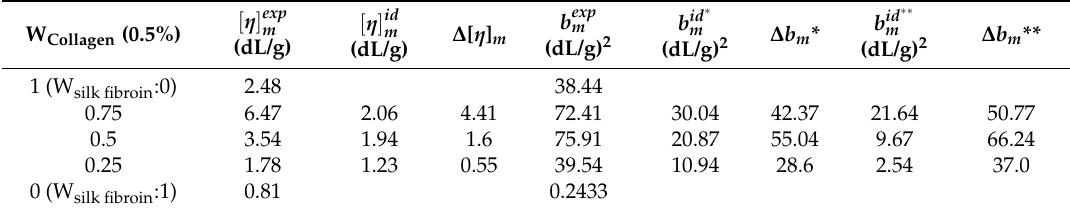
Table 2. Theoretical (by Krigbaum and Wall [28] and Garcia et al. [29] methods) and experimental values for pure collagen, pure silk fibroin and the mixtures. W Collagen